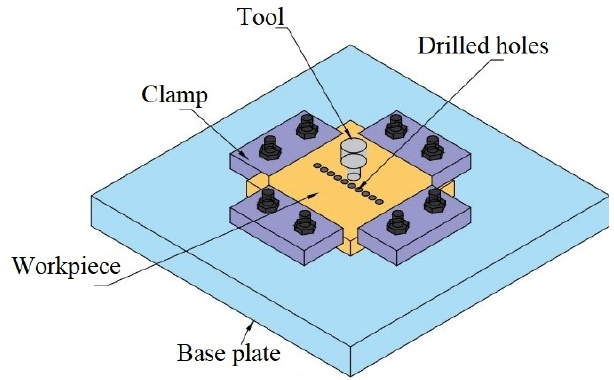
Figure 1. Fabricated setup for the